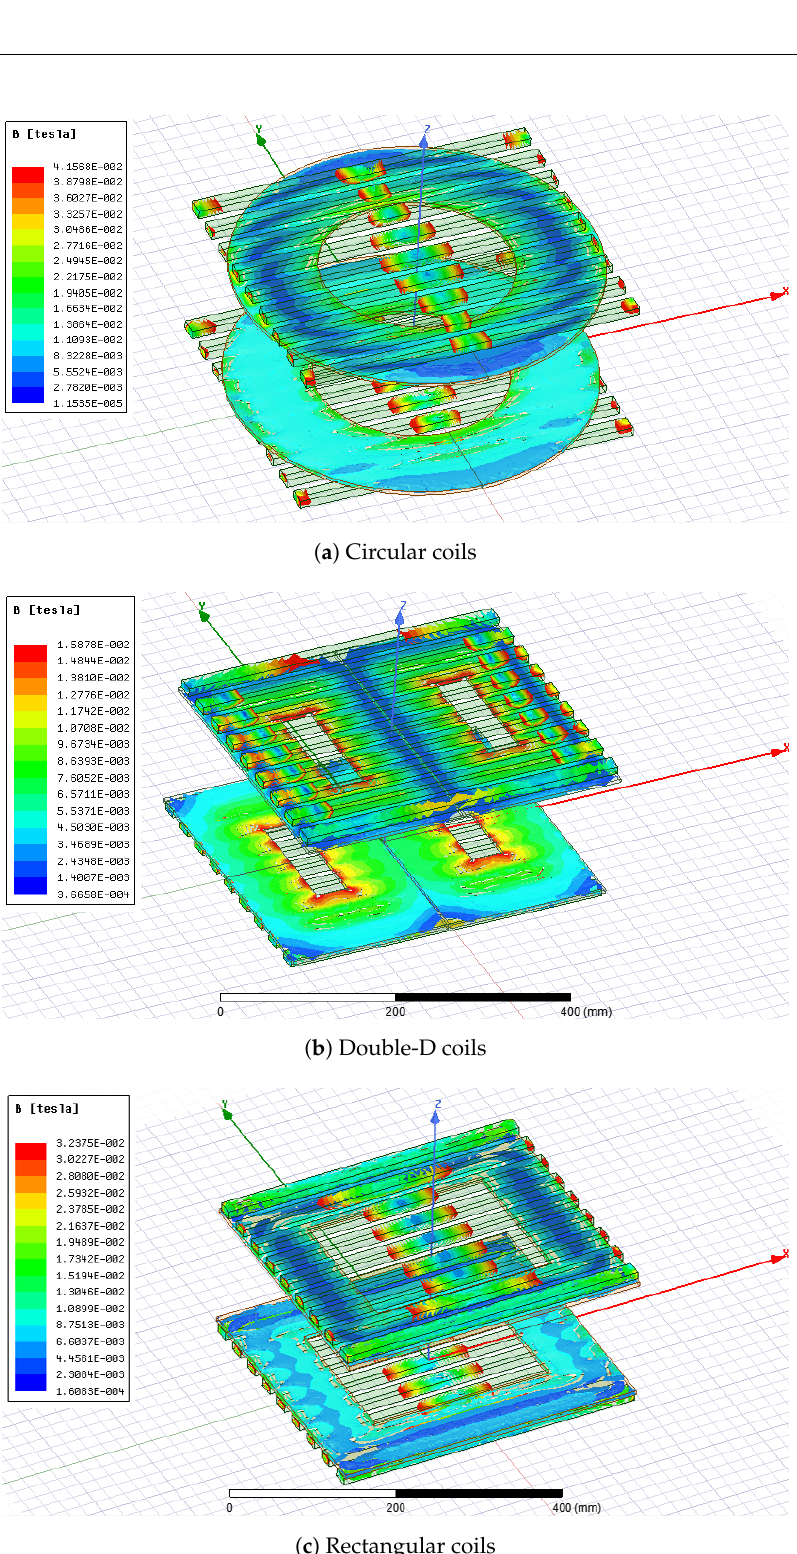
Figure 4. Three-dimensional magnetic field distribution in three coil geometries with 150 mm axial